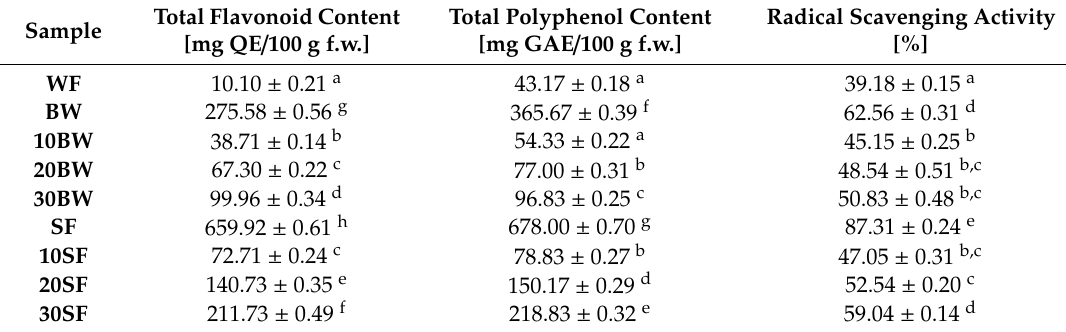
Table 5. Total flavonoids, total phenols and radical scavenging activity of flour samples. Total Flavonoid Sample